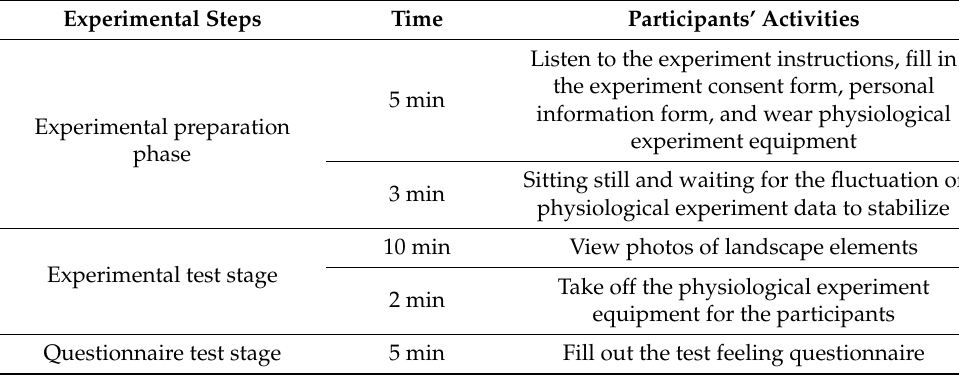
Table 3. Experimental flow.